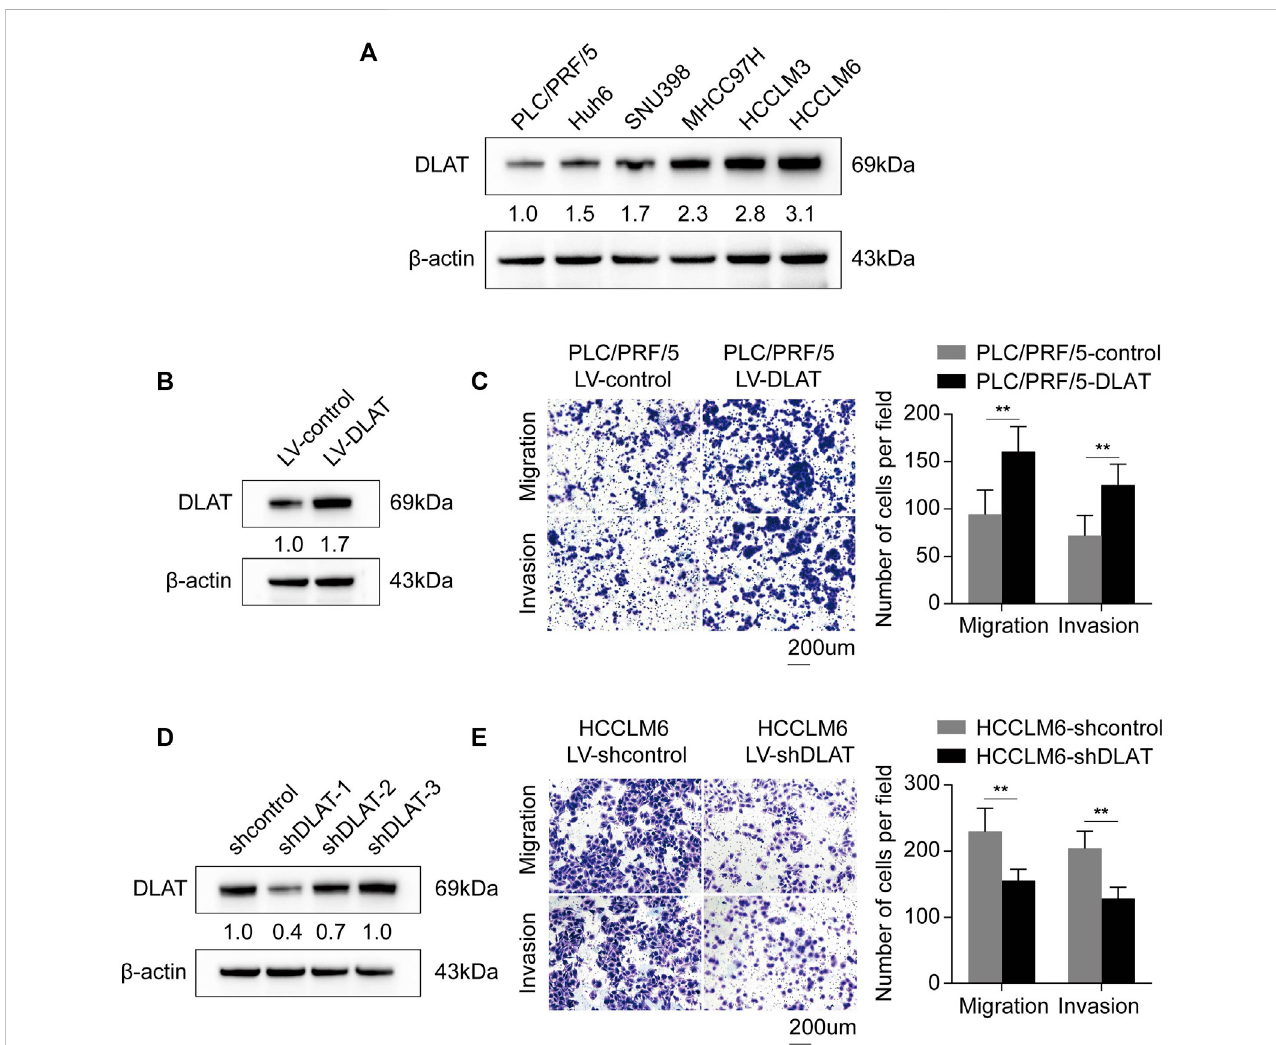
FIGURE 7 Upregulated DLAT enhances HCC cell migration and invasion capacities. (A) The expression status of DLAT in HCC cell lines. (B) The result of Western blotting con fi rmed that DLAT was upregulated in PLC/PRF/5 treated with DLAT-overexpressing lentivector. (C) Overexpression of DLAT promoted migration andinvasionabilitiesofPLC/PRF/5. (D) Theresultofwesternblottingcon fi rmedthatDLATwassigni fi cantlyknockeddowninHCCLM6. (E) Downregulationof DLAT in HCCLM6 inhibited migration and invasion abilities of